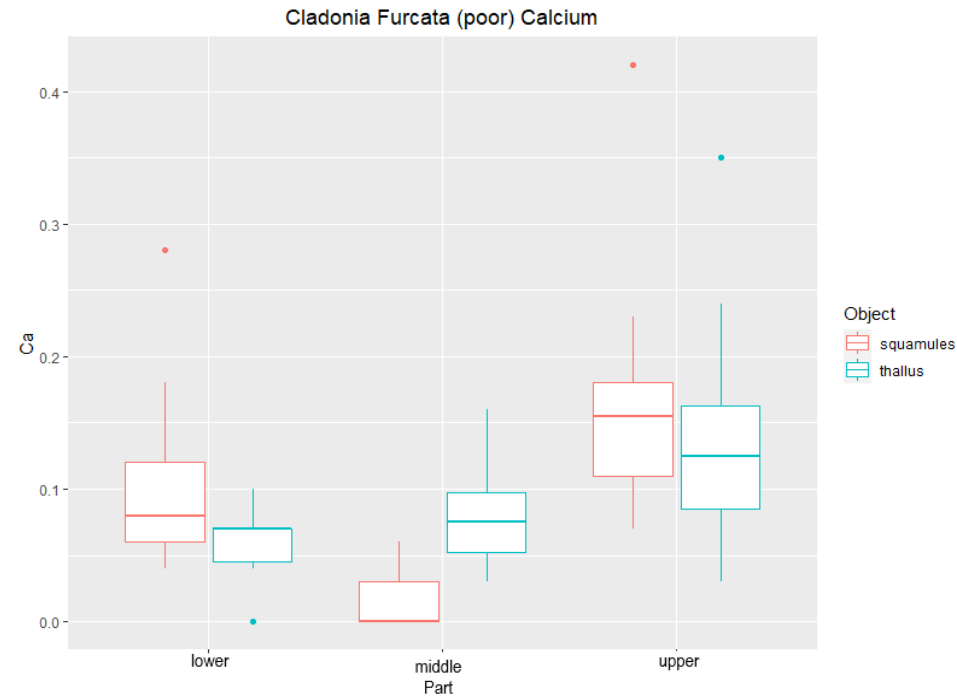
Figure 3. Content of Ca (DW%) in lichen thallus and squamules of Cladonia furcata collected from calcium-poor sites ( n = 5). “Lower”, “middle”, and “upper” designate the location of the measured area.